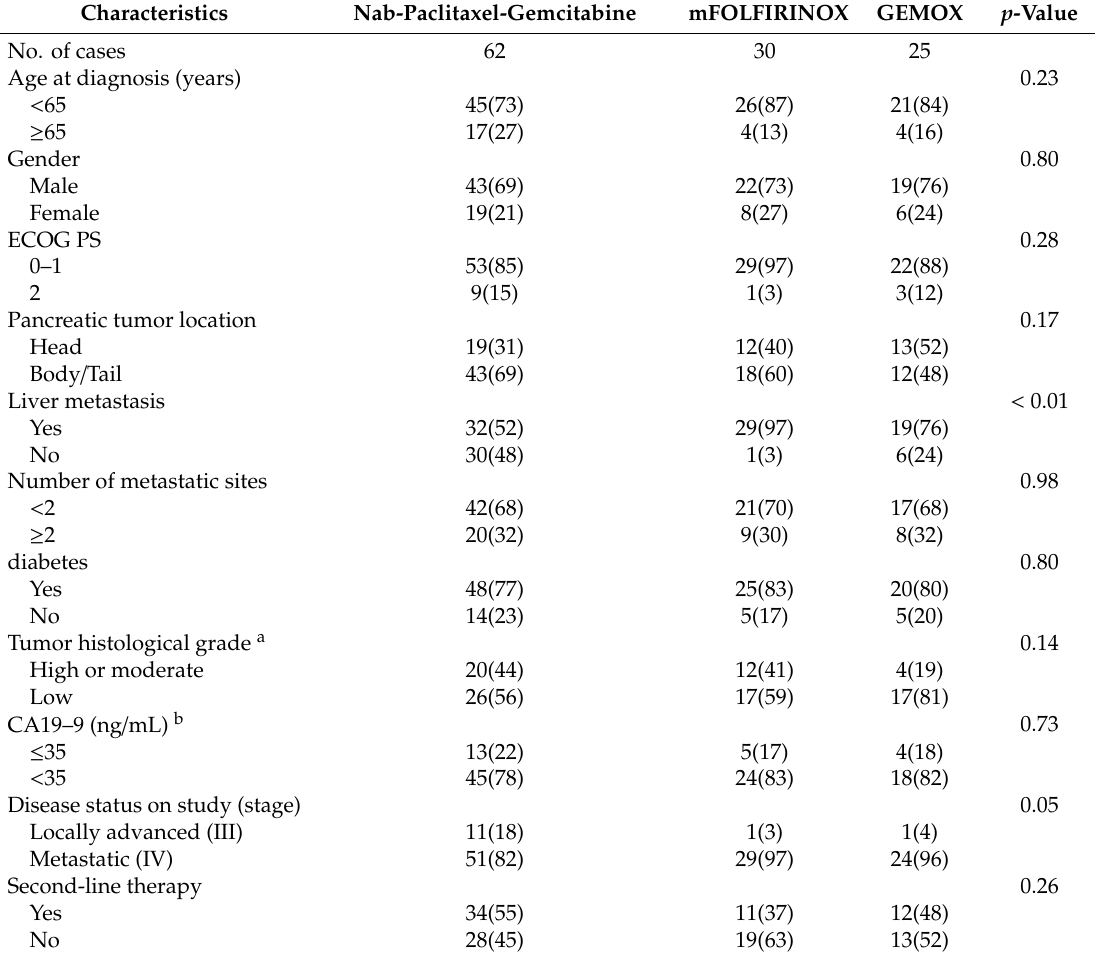
Table 1. Baseline characteristics among eligible patients with unresectable pancreatic